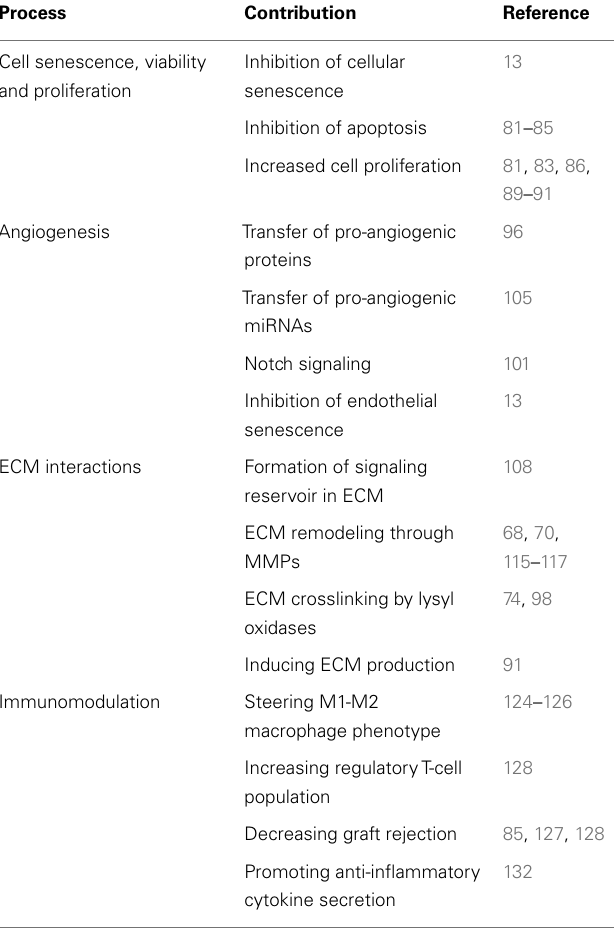
Table 1 | Functional relevance of EV in regenerative processes